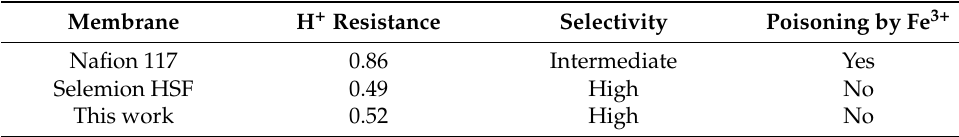
Table 2. Comparison of the performance of different membranes.